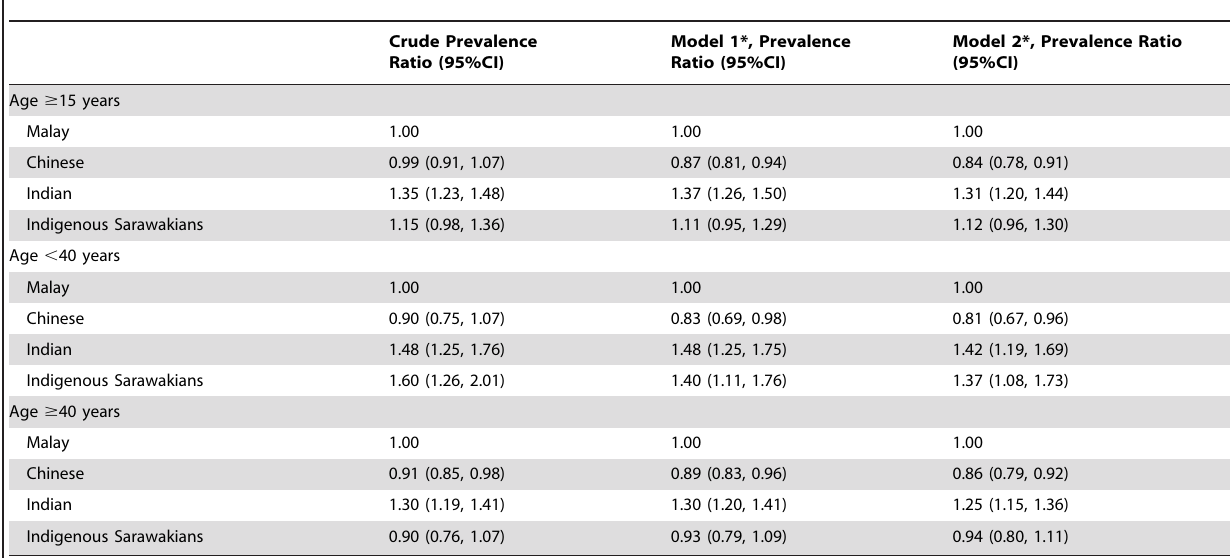
Table 3. Association between metabolic syndrome and ethnicity by